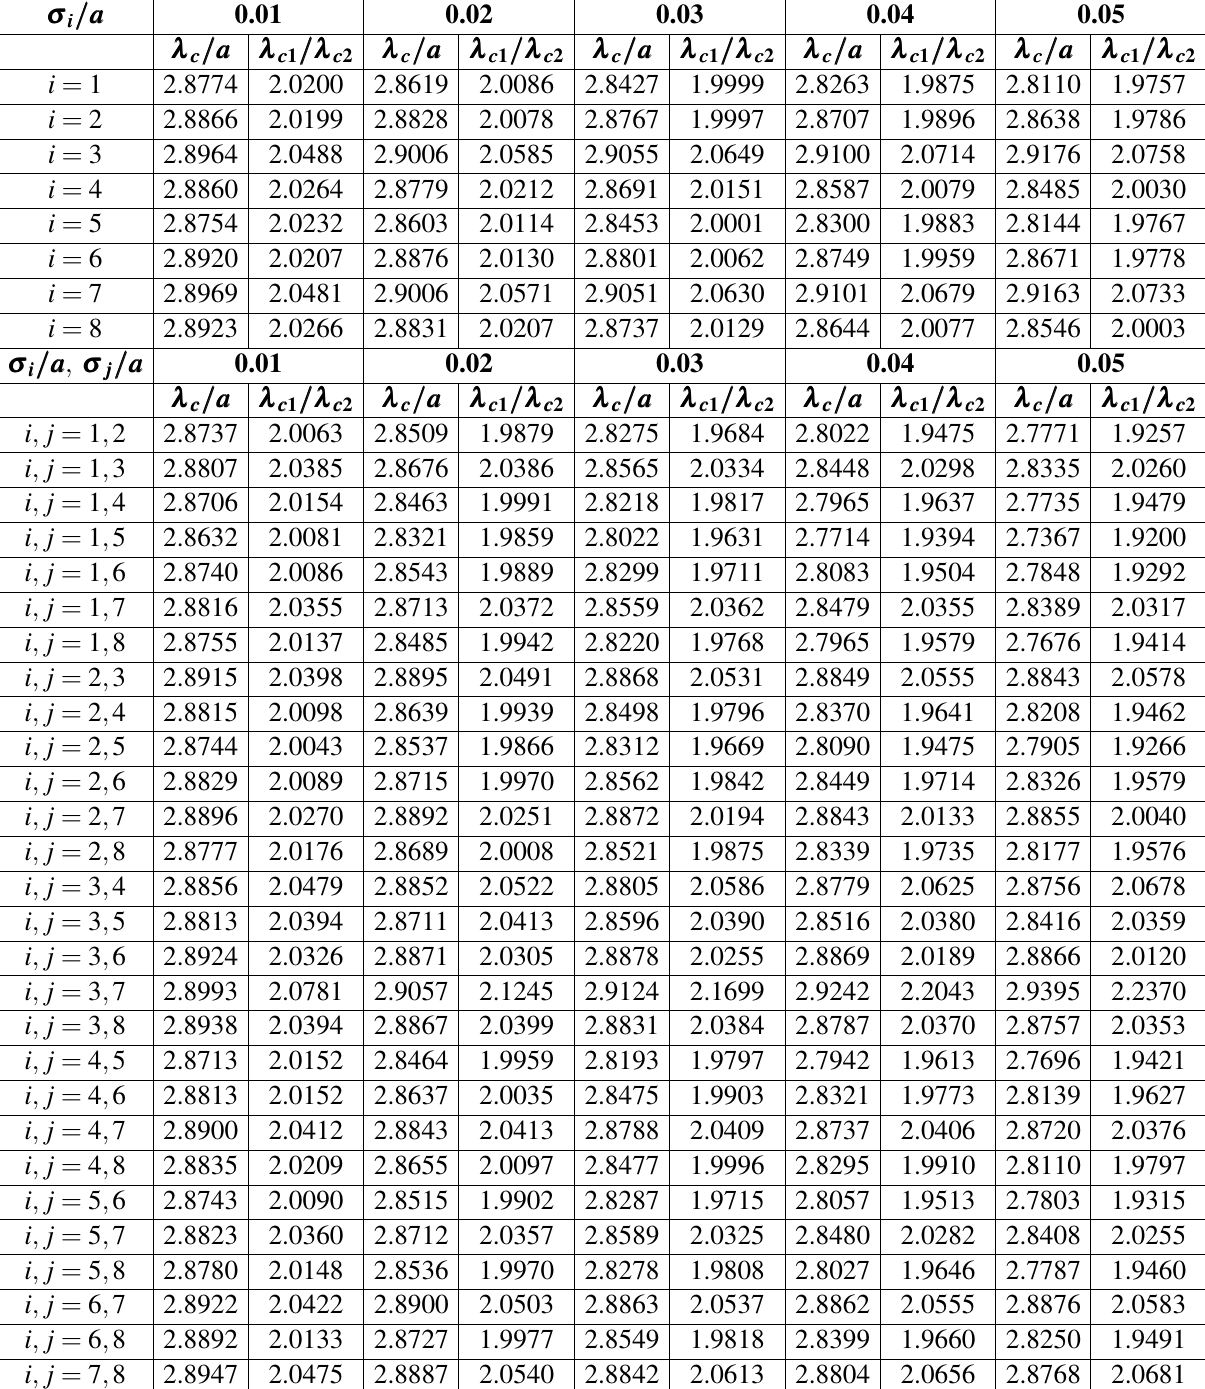
Table 4 The changes of λ c / a and λ c 1 / λ c 2 in deformed antipodal